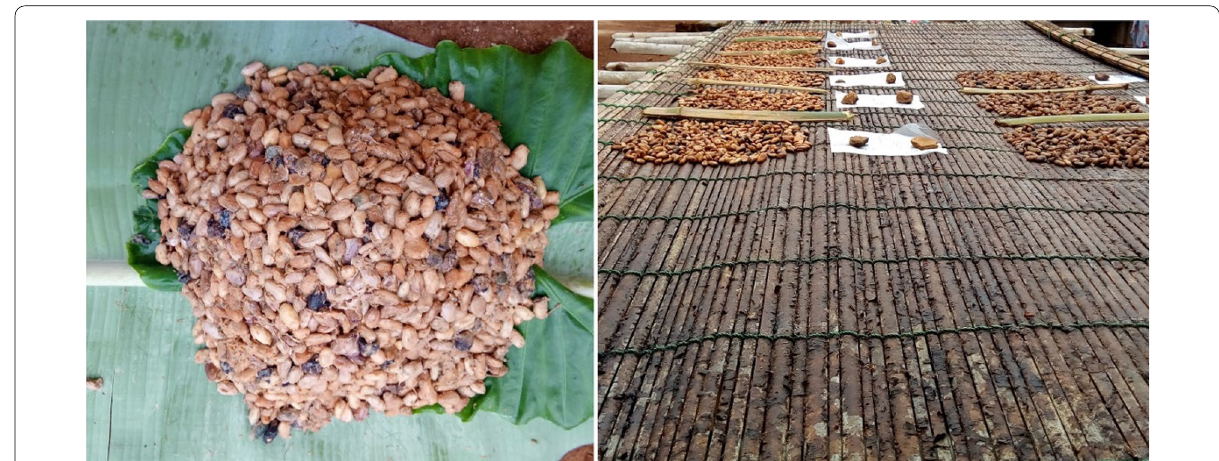
Fig. 1 Fermentation and Drying of sampled cocoa beans with traditional leaf heap method and sun